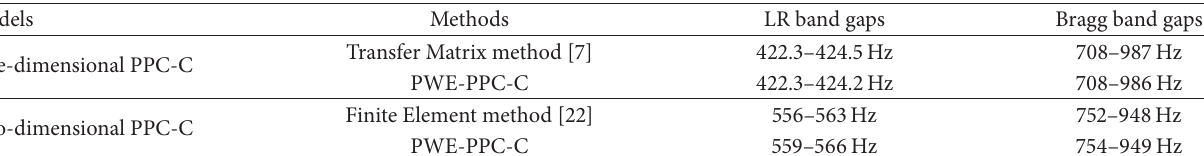
Table 2: Comparisons between PWE-PPC-C and other methods.